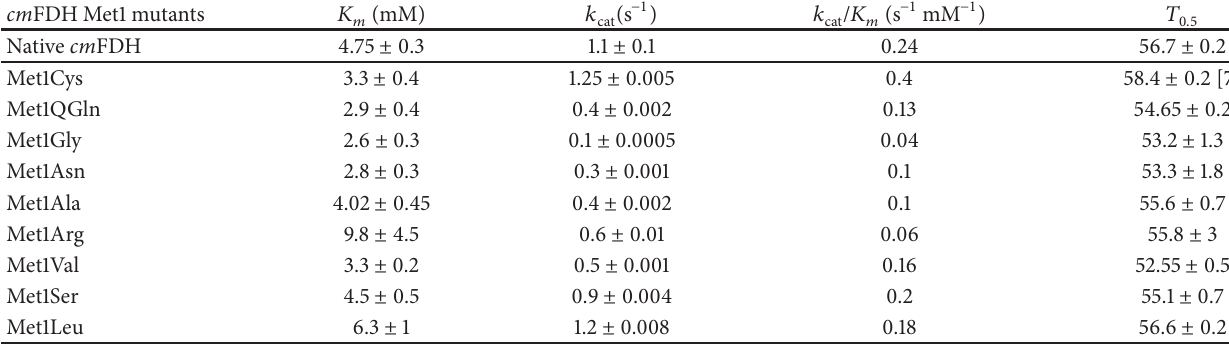
Table 2: Activity and 𝑇 0.5 values of site saturation mutants on Met1 position of cm FDH.